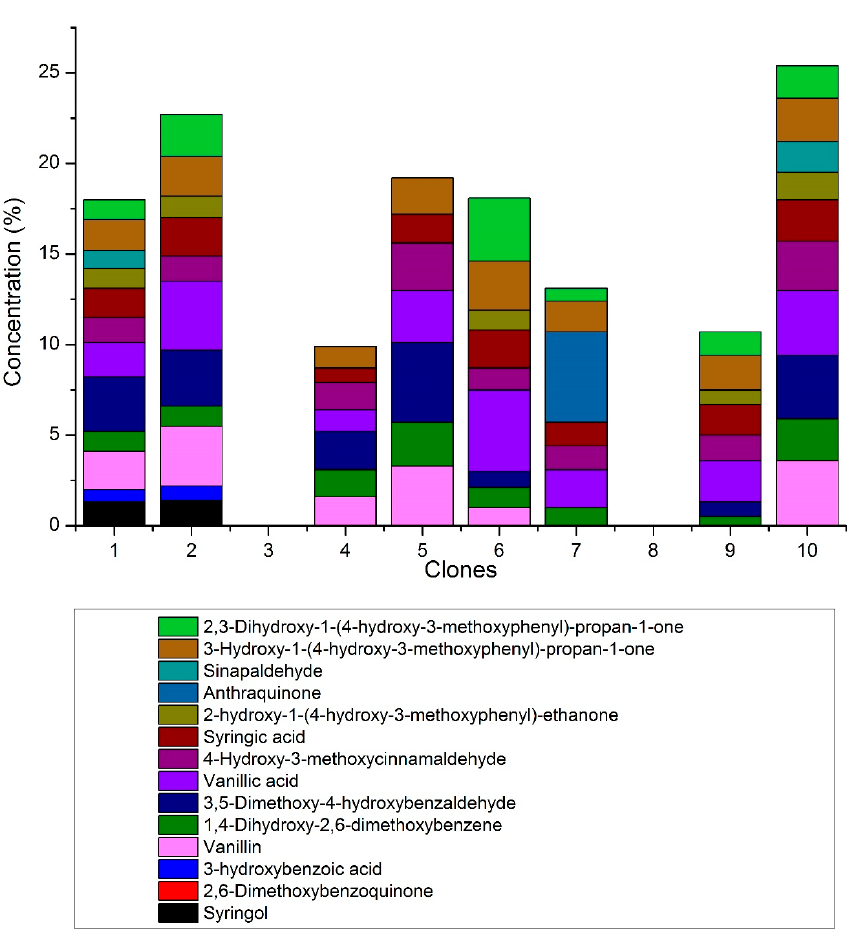
Figure 4. Aromatic constituents of Eucalyptus spp. identified in lipophilic extracts obtained with dichloromethane.